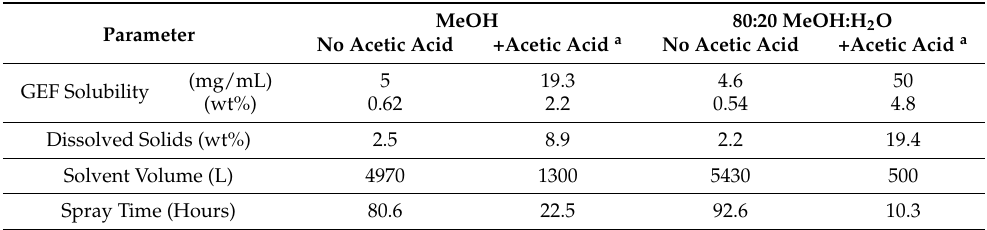
Table 3. Throughput estimate for 100 kg of 25% GEF SDD assuming maximum API solubility of GEF shown in Figure 2, assuming a solution feed rate of 50